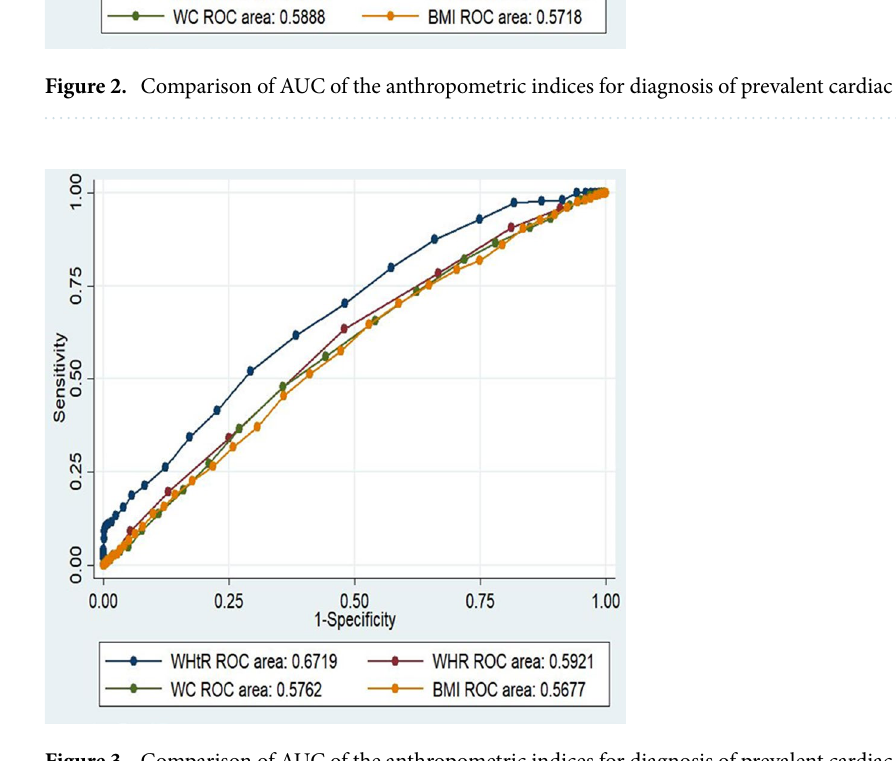
Figure 3. Comparison of AUC of the anthropometric indices for diagnosis of prevalent cardiac event in